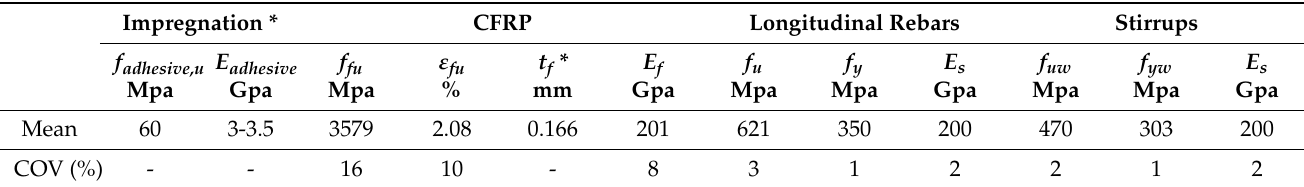
Figure 3. Unidirectional carbon-fiber sheet.